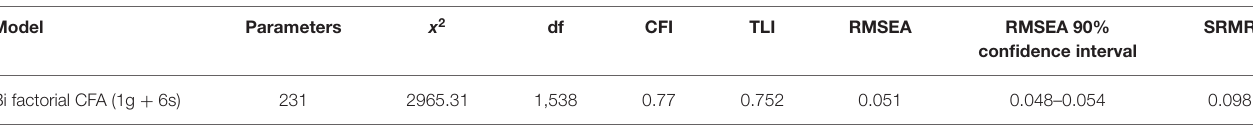
TABLE 2 | Descriptive fit indices of bifactorial confirmatory